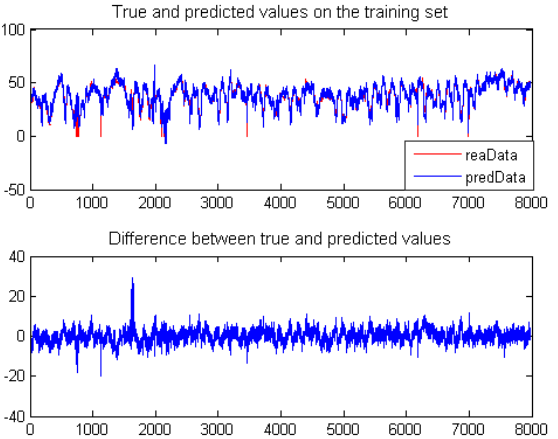
Figure 2. Prediction of pitch motor temperature by ESN model on training data set.